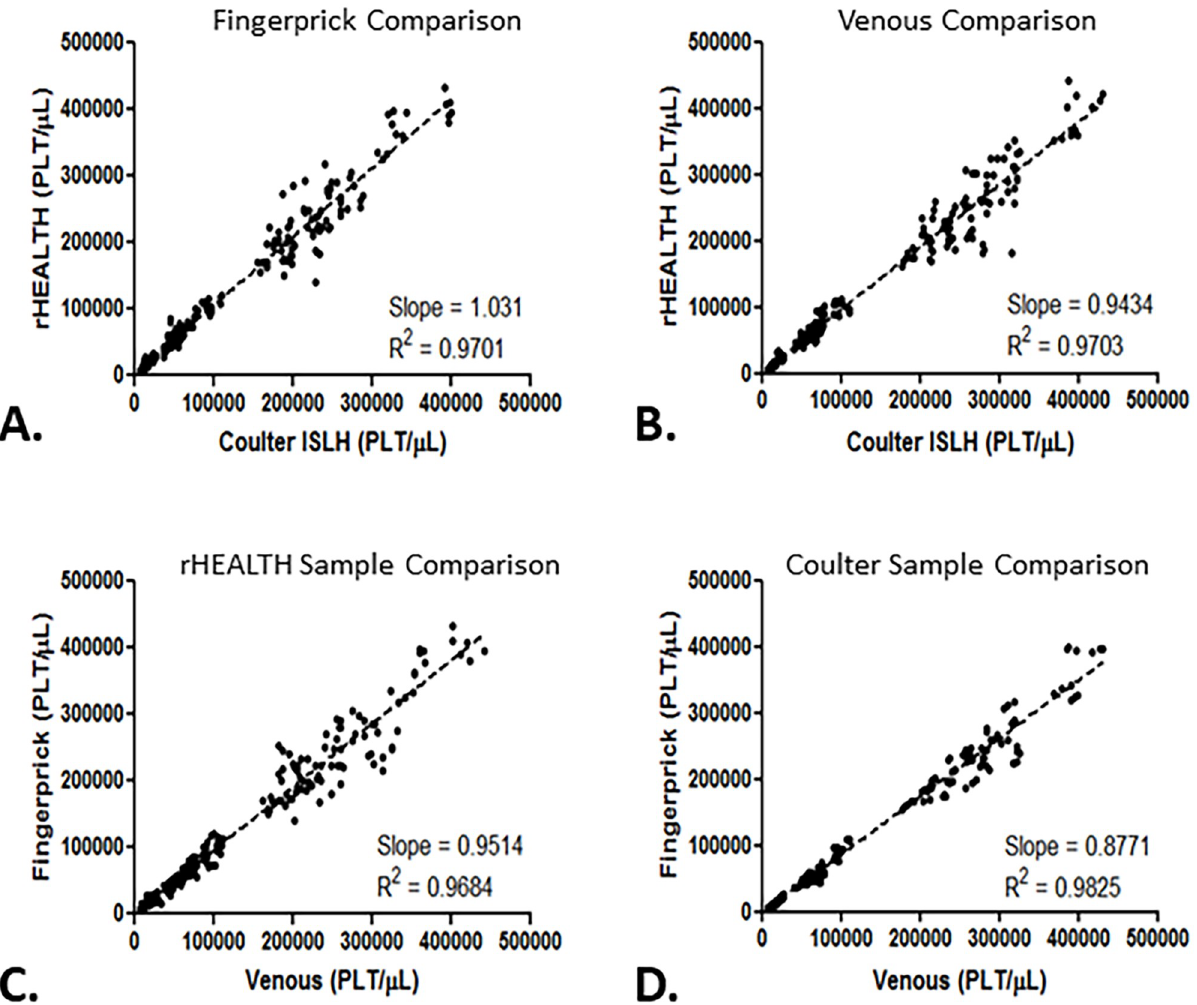
Fig 2. Performance of rHEALTH and Coulter ISLH for fingerstick and venous samples. Plot of rHEALTH absolute volumetric PLT counts versus Coulter ISLH for (A) fingerprick samples and (B) venous samples. Plot of venous platelet counts versus fingerprick platelet counts using Coulter ISLH and the rHEALTH absolute volumetric PLT for (C) rHEALTH and (D) Coulter. Platelet concentrations for all are in plt/ μ L and the trend line equation and R 2 are